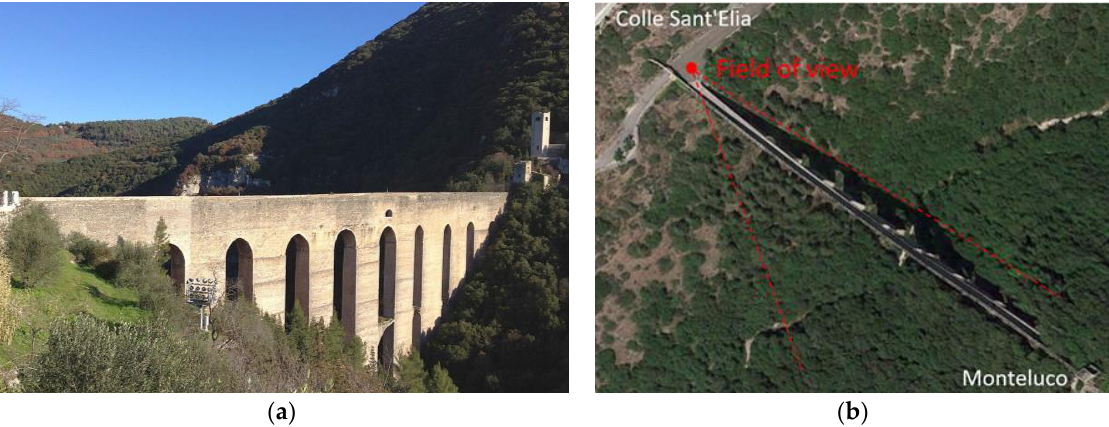
Figure 8. The Ponte delle Torri, Spoleto, Italy: ( a ) view from west; ( b ) aerial view of the bridge with the video acquisition geometry, with camera position and field of view enhanced in red (from Google Maps).